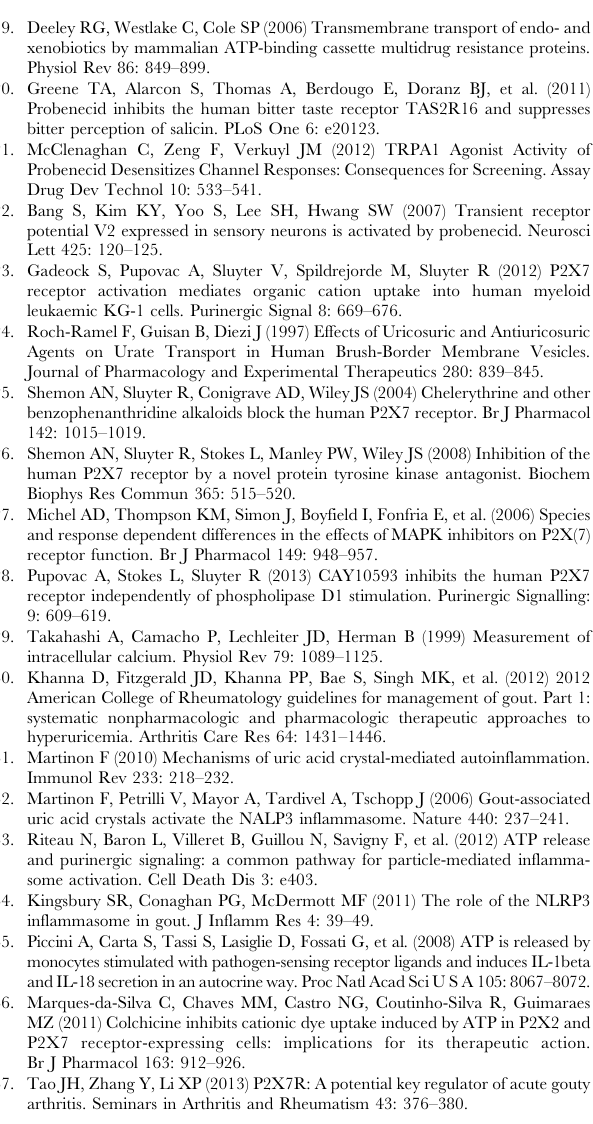
Figure S1 CBX and PRO reduce spontaneous YO-PRO uptake in HEK-293 cells transfected with pannexin-1. YO-PRO iodide uptake was induced in HEK-293 cells expressing pannexin-1 by injection of the dye (40 seconds) to a final concentration of 5 m M. Cells were incubated in buffer alone (red), 100 m M CBX (blue) or 2.5 mM PRO (purple) for 10 minutes before dye injection. Fluorescence was measured using a Fluostar